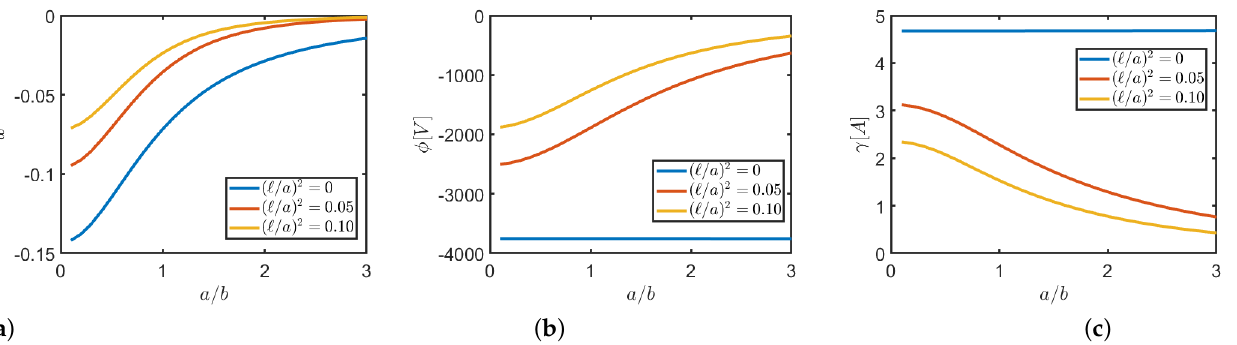
Figure 5. Graphs of displacement ¯ w ( a ) electric φ ( b ) and magnetic γ ( c ) potential, in the point ( a /2, b /2 ) to vary of a / b ratio and for different values of nonlocal parameter ( (cid:96) / a ) 2 and for n p = 1. (SDL; q = 0 N/m 2 , T 0 = T 1 = 0 K, ρ E = 0.1 C/m 2 , ρ H = 0 Wb/m 2 )